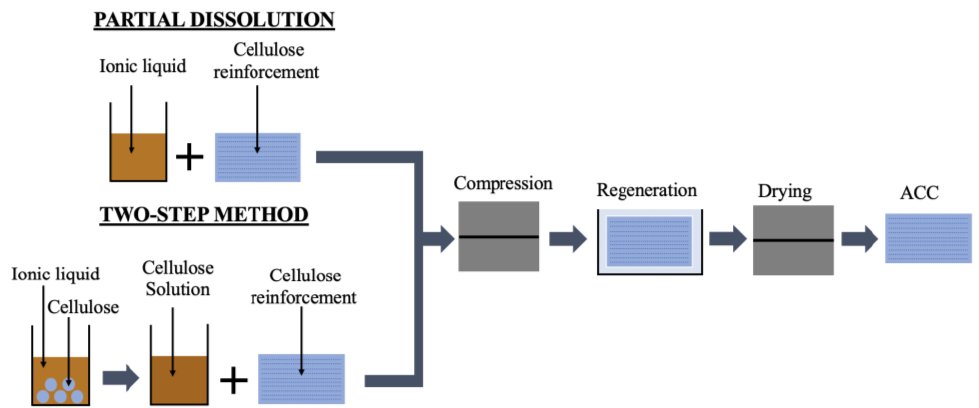
Figure 1. Illustration of the partial dissolution (one-step) and complete dissolution (two-step) meth- ods.